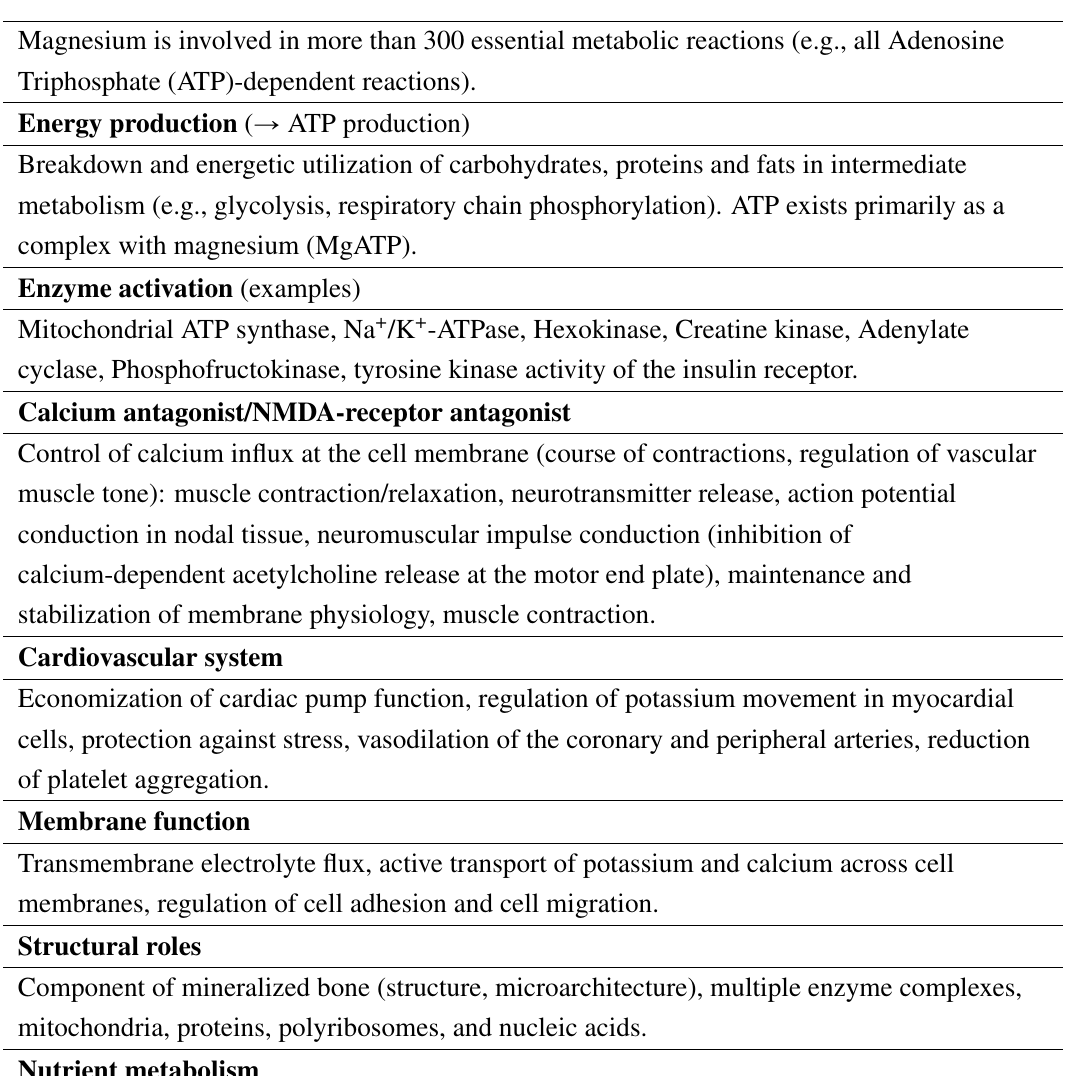
Table 1. Functions of magnesium (selection)